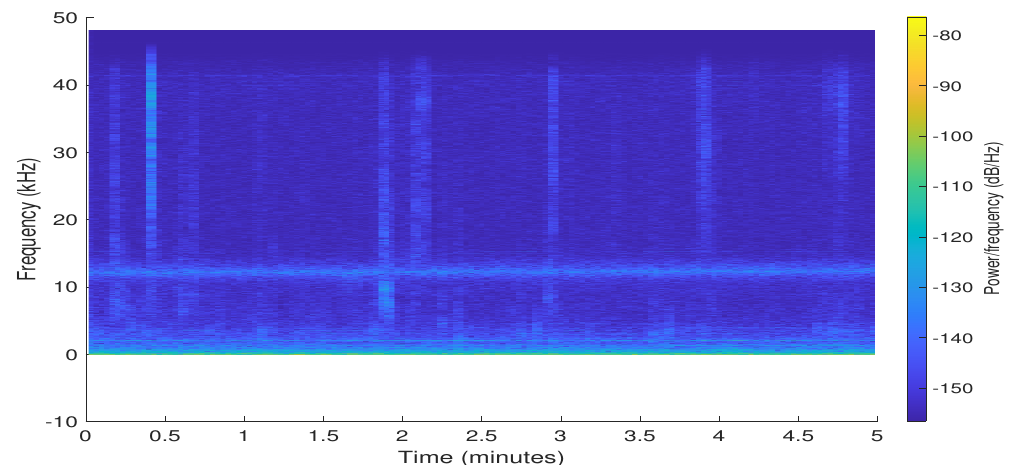
Figure 29. Analysis of USB-DAQ S device: Spectrogram of time versus frequency of an underwater acoustic